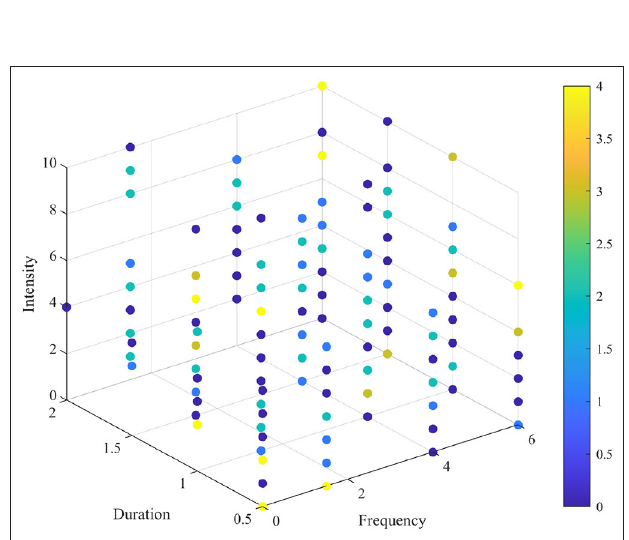
FIGURE 3 | The distribution diagram of colds combined with intensity, frequency, and duration. The color of points means the number of colds in the last